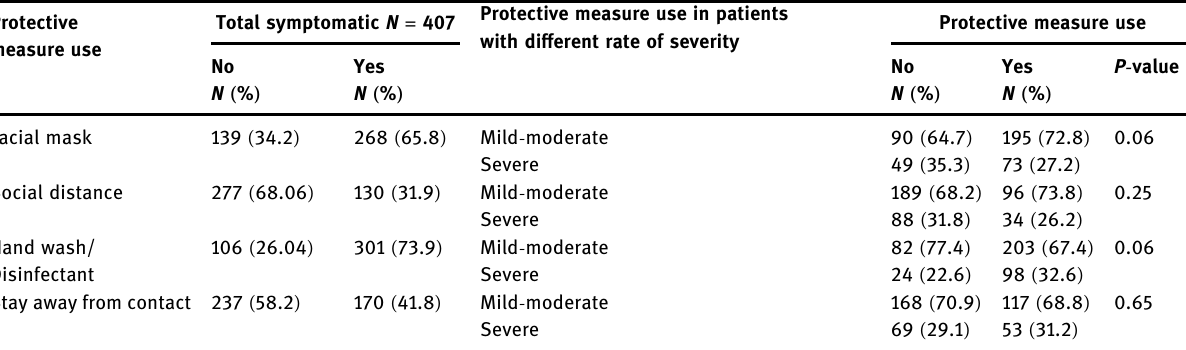
Table A1: The frequency of protective measure use before contracting the disease between patients with mild - moderate and severe infection